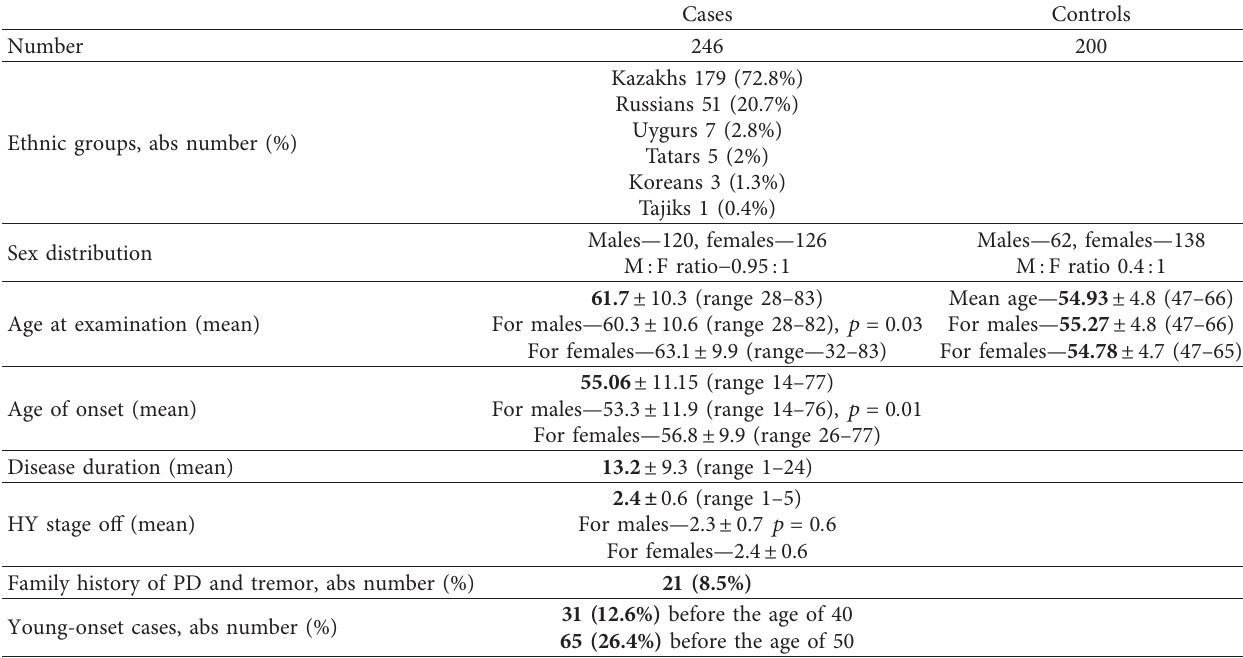
Table 1: Clinical and demographic characteristics of the